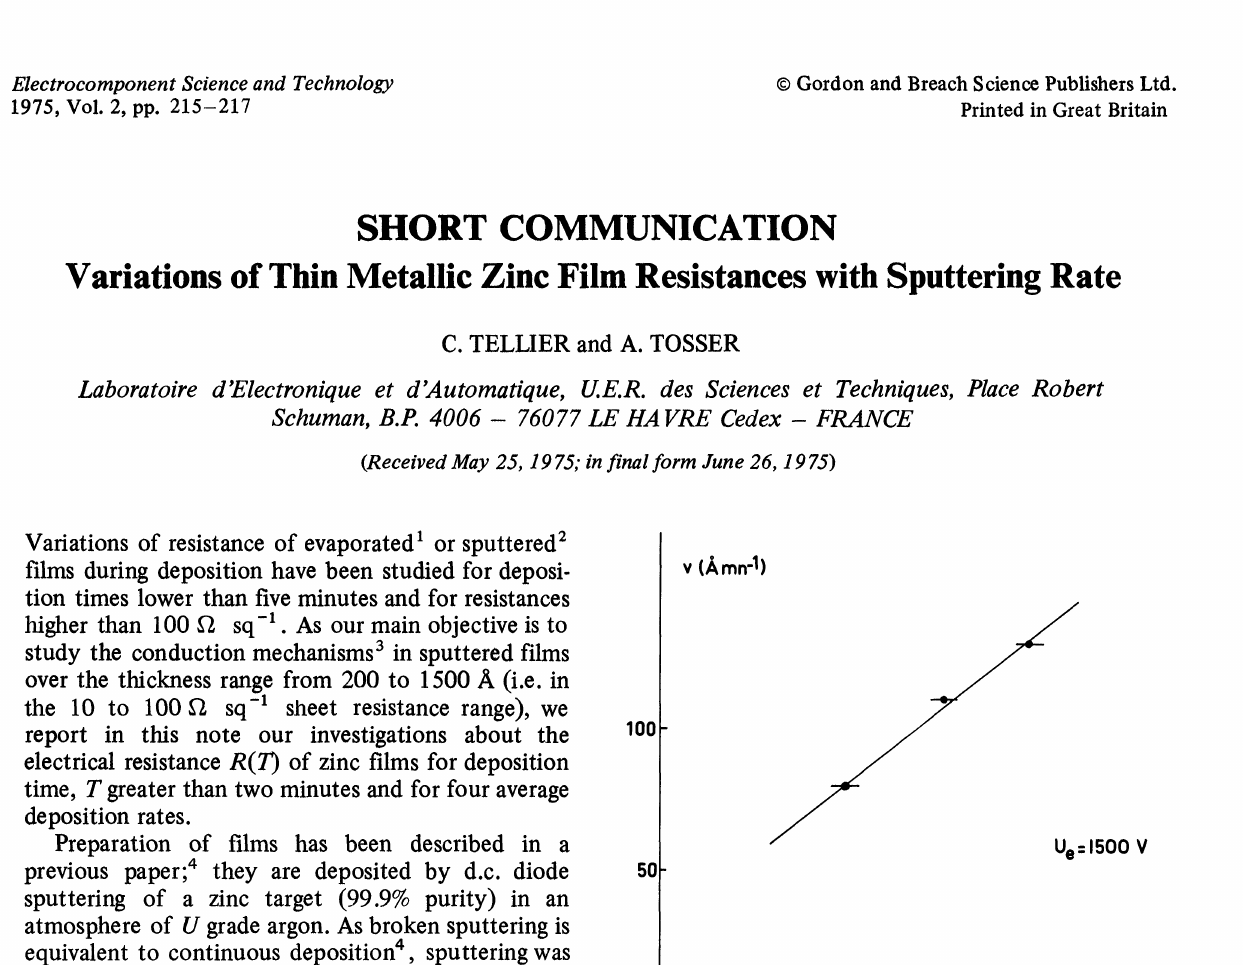
deposition time T are plotted in Figure 2. Attempts have been made 1’2 to fit these experimental varia- tions to an empirical equation in the